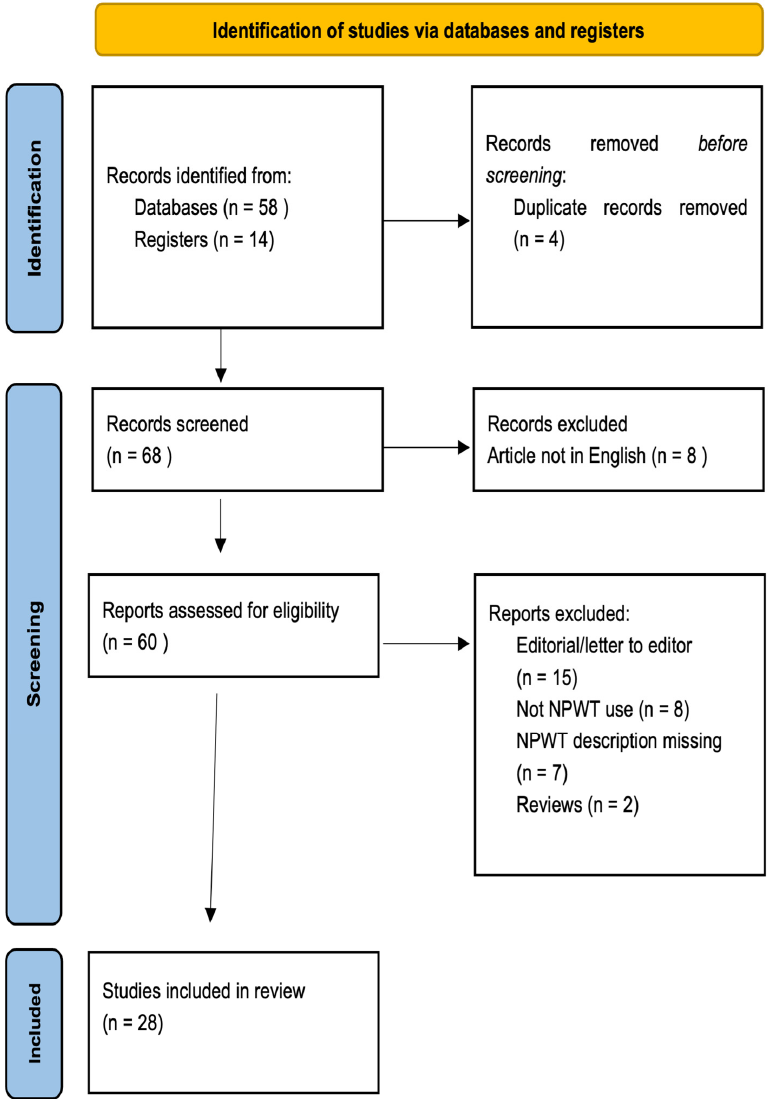
Figure 1. PRISMA flow diagram [12]. For more information, visit: http://www.prisma-state- ment.org/.; date of first access: 10/02/2020. org/; date of first access: 10 February